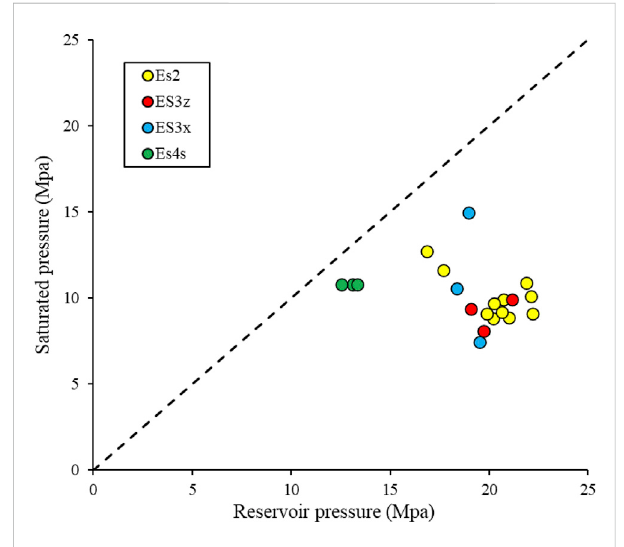
FIGURE 4 Plot of reservoir pressure versus saturation pressure for different formations in the study